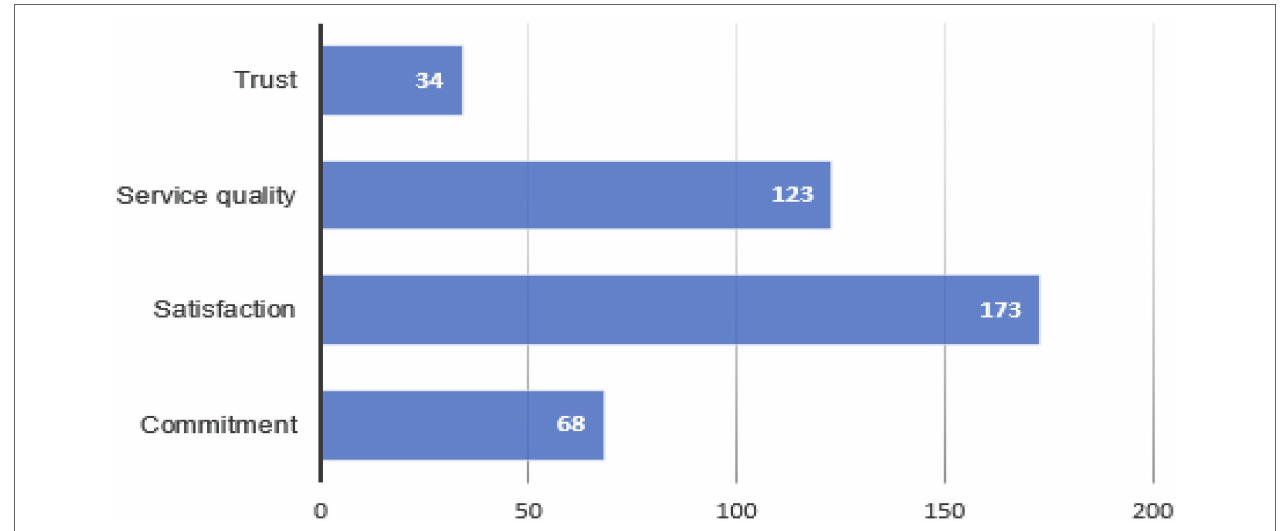
FIGURE 5 | Distribution of antecedents that explain loyalty over total